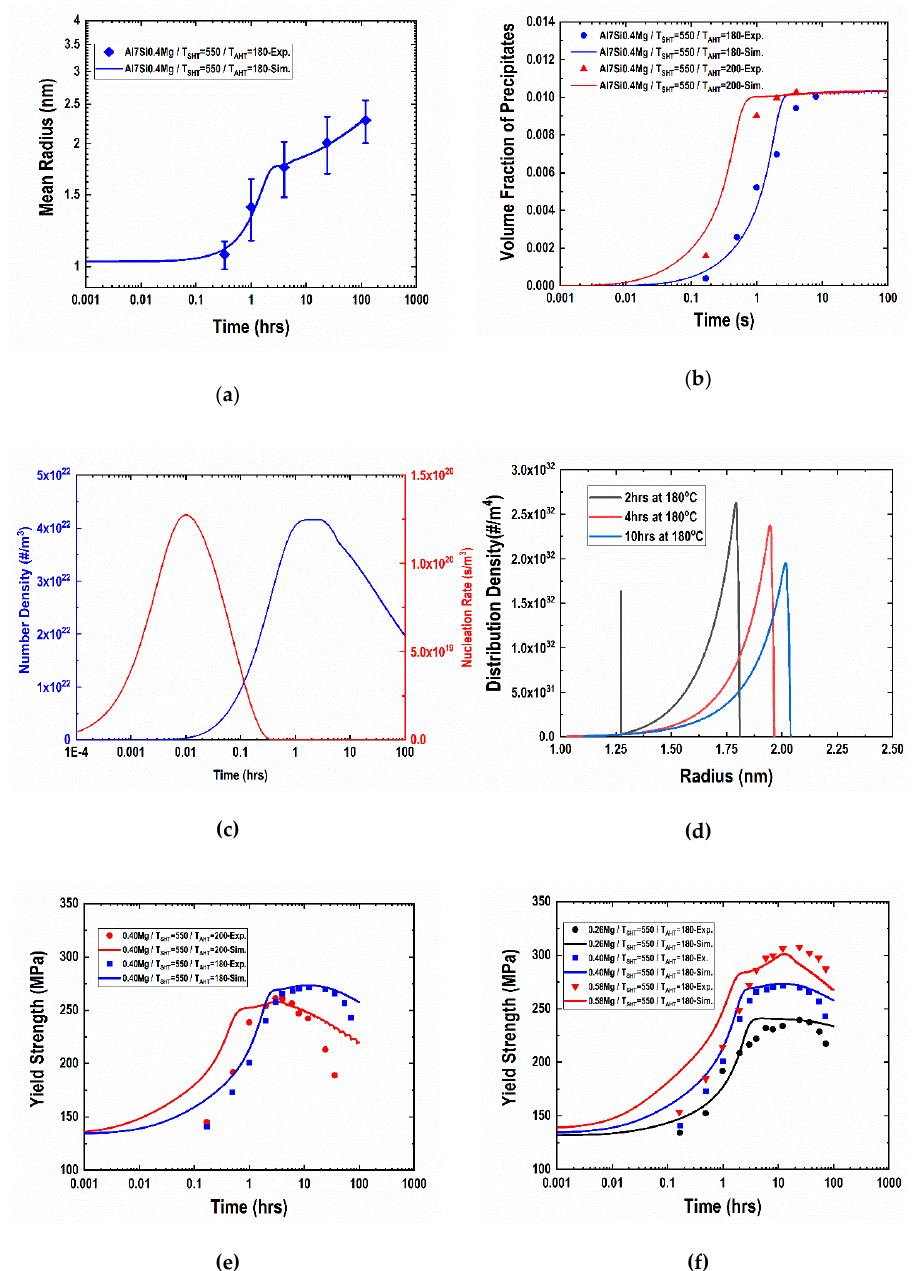
Figure 3. The optimization of integrated precipitation and strengthening models: ( a ) calculated mean tip radius of needle β (cid:48)(cid:48) precipitates and comparison to the experimental data; ( b ) calculated volume fraction of needle β (cid:48)(cid:48) precipitates and comparison to the experimental data; ( c ) the evolution of particle nucleation rate and number density at 180 °C ( d ); the evolution of particle size distribution (PSD) with time; ( e ) the comparison of simulated and experimental yield strength for two different aging temperatures; ( f ) the comparison of simulated and experimental yield strength for three different levels of Mg.